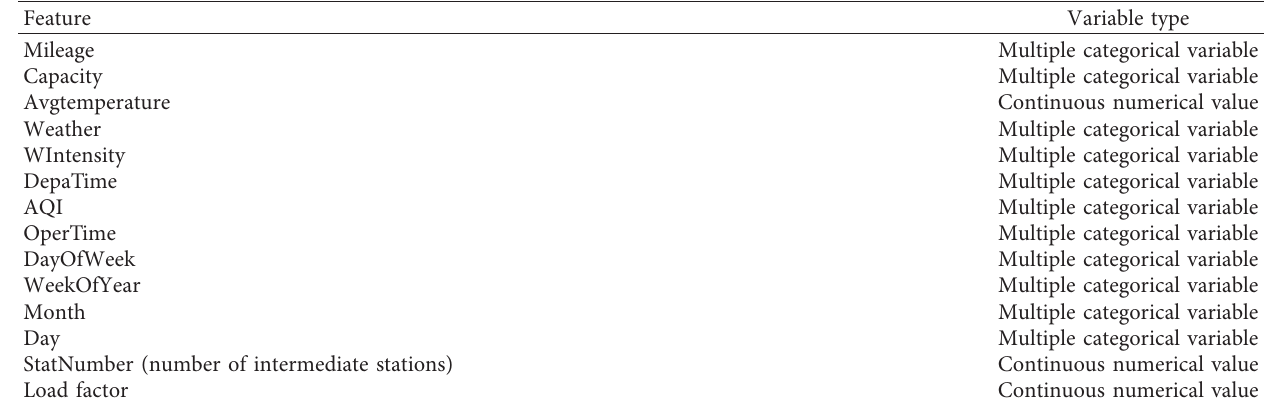
Table 1: Features of train passenger load factor